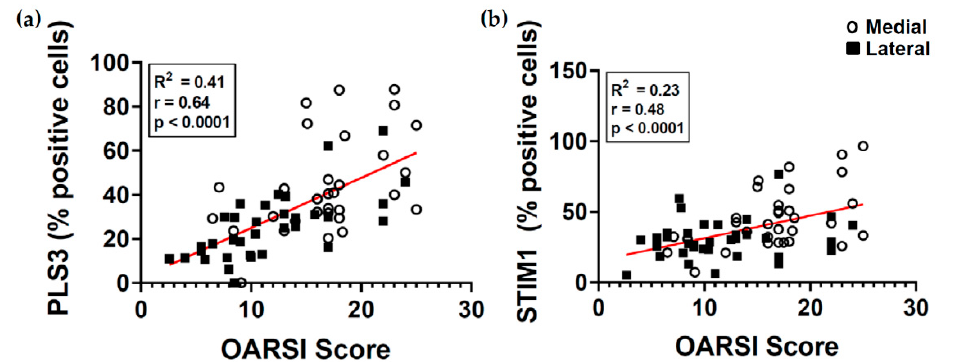
Figure 6. Correlations between the staining of PLS3 and STIM1 with the OARSI score. Scatter plot and linear regression of correlation between ( a ) PLS3 staining (% positive cells) and OARSI score and ( b ) STIM1 staining (% positive cells) and OARSI score. To test the correlation between variables, the Pearson’s correlation coefficient was calculated.